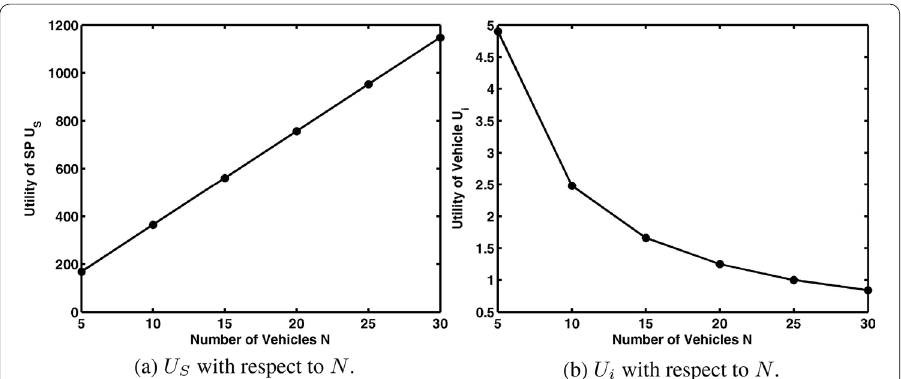
Fig. 8 The performance of incentive mechanism with respect to the number of vehicles